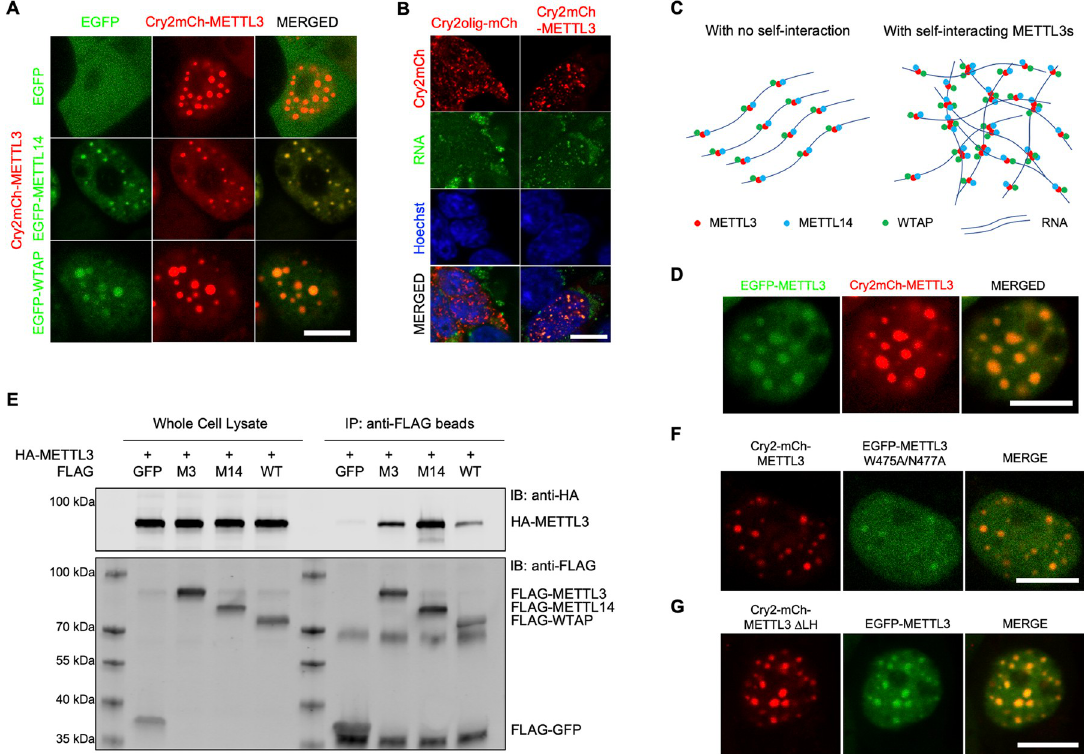
Fig 2. Self-interaction of METTL3 provides multivalency for LLPS of the writer complex. (A) Representative images showing localization of EGFP control, EGFP-METTL14 or EGFP-WTAP after Cry2-mCh-METTL3 condensates formation by light stimulation. Scale bar = 10 μ m. (B) Colocalization of RNA (SYTO RNAselect live cell stain) and Cry2-mCh-METTL3 condensates. Cry2olig-mCh (Addgene #60032) is used as light-inducible oligomerization control. Scale bar = 10 μ m. (C) Hypothetical models of intermolecular interactions mRNA m 6 A methyltransferase complex with (right) or without (left) self-interacting ability of METTL3. (D) Representative images showing localization of EGFP-METTL3 after Cry2-mCh-METTL3 condensates formation by light stimulation. (E) Co- immunoprecipitation assay with HEK293T coexpressing HA-METTL3 and FLAG-tagged METTL3 (M3), METTL14 (M14), or WTAP (WT). (F) Recruitment of METTL14 binding–deficient mutant METTL3 into Cry2-mCh-METTL3 liquid condensates. Scale bar = 10 μ m. (G) Recruitment of METTL3 into Cyr2-mCh-METTL3 Δ LH mutant liquid condensates. Scale bar = 10 μ m. LLPS, liquid– liquid phase separation; METTL3, methyltransferase-like 3; METTL14, methyltransferase-like 14; WTAP, Wilms tumor suppressor-1– associated